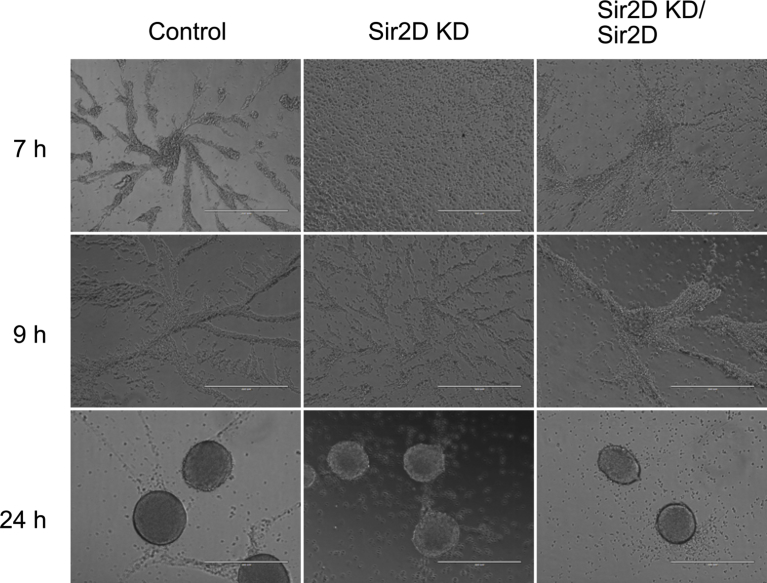
Supplementary Fig. S4.eps